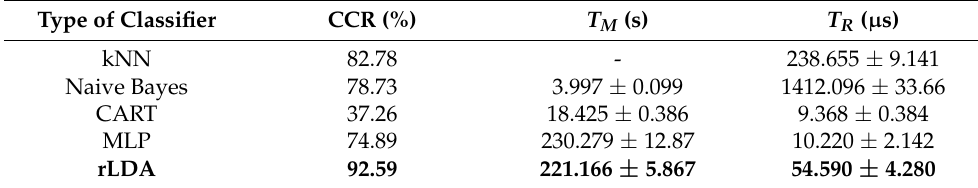
Table 6. Classification results for individual classifiers with Group 5 attributes.